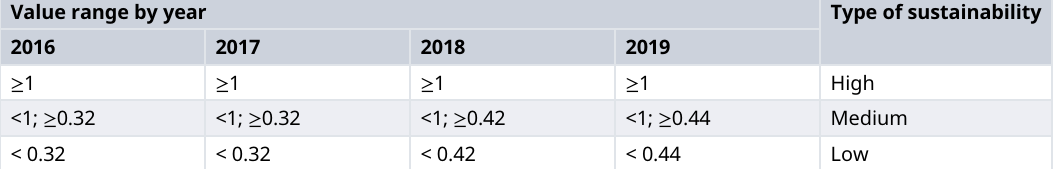
Table 6. The scale of values of the regional debt sustainability index (I DS ) (the authors ’ calculations). Value range by